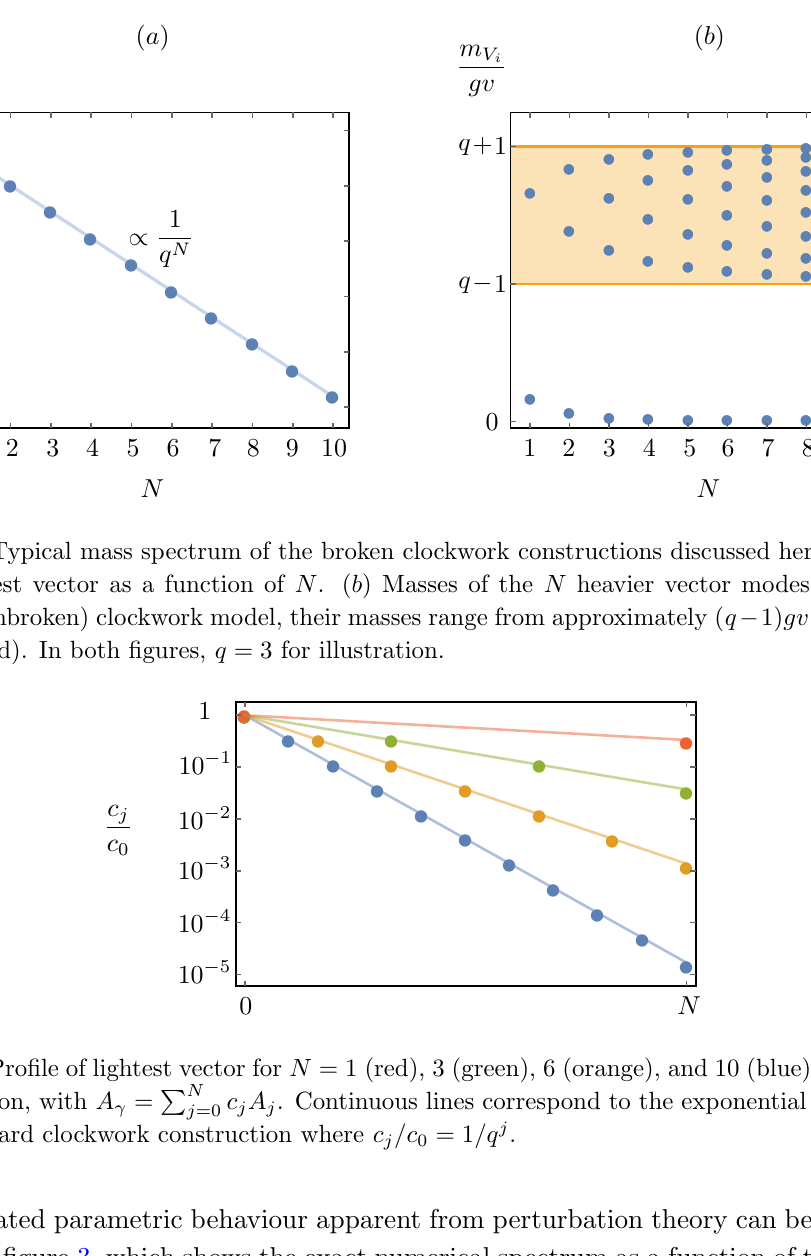
Figure 4 . Pro(cid:12)le of lightest vector for N = 1 (red), 3 (green), 6 (orange), and 10 (blue), with q = 3 for illustration, with A (cid:13) = P N c j A j . Continuous lines correspond to the exponential localization j =0 of the standard clockwork construction where c j =c 0 = 1 =q j